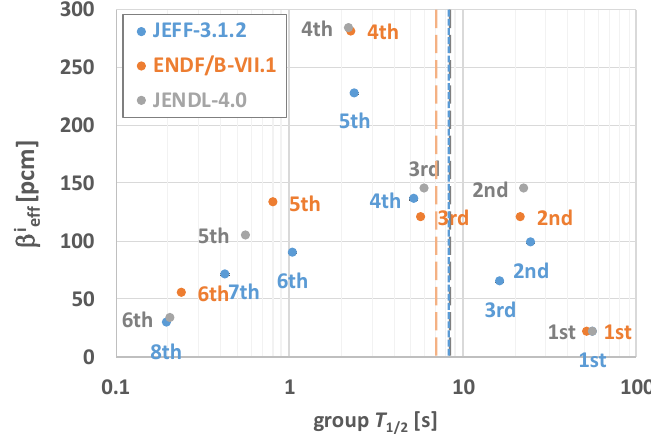
Fig. 4. Core averaged abundances of delayed neutron precursors in dependence of the half-life (in log-scale). Calculated with MCNP using JEFF-3.1.2 (8 groups), JENDL-4.0 and ENDF/B-VII.1 (6 groups) libraries. The uncertainties are ≤ 1 pcm in all cases. The average half-life of each of the three data sets is shown with a dashed line.